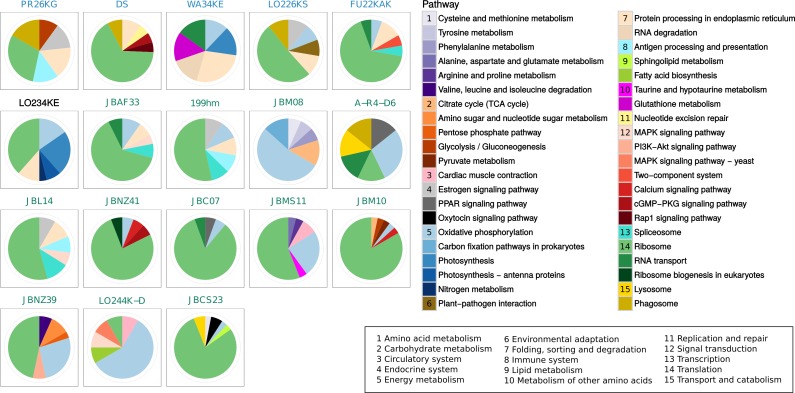
Most highly expressed pathways per sample, such that contained genes explain 50% of the total expression.Pathways are coloured and grouped according to their KEGG hierarchy II displayed below the pathway legend, e.g., all blue colours, number 5, belong to energy metabolism. Samples names are sorted and coloured according to Fig. 1.